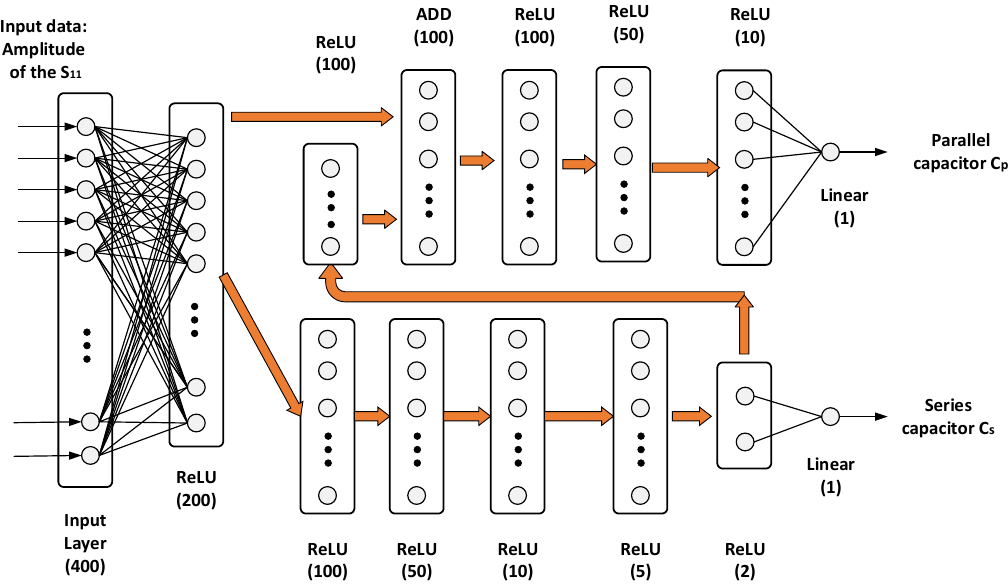
Figure 5. Architecture of the proposed DNN for antenna impedance matching.